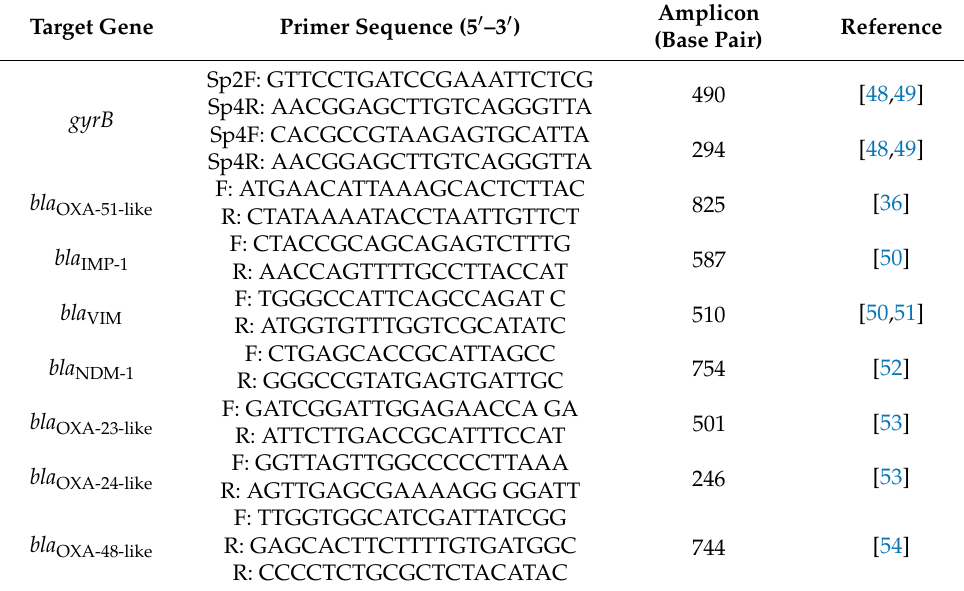
Table 5. Primers used to identify the Acinetobacter baumannii species and carbapenemase genes. Target